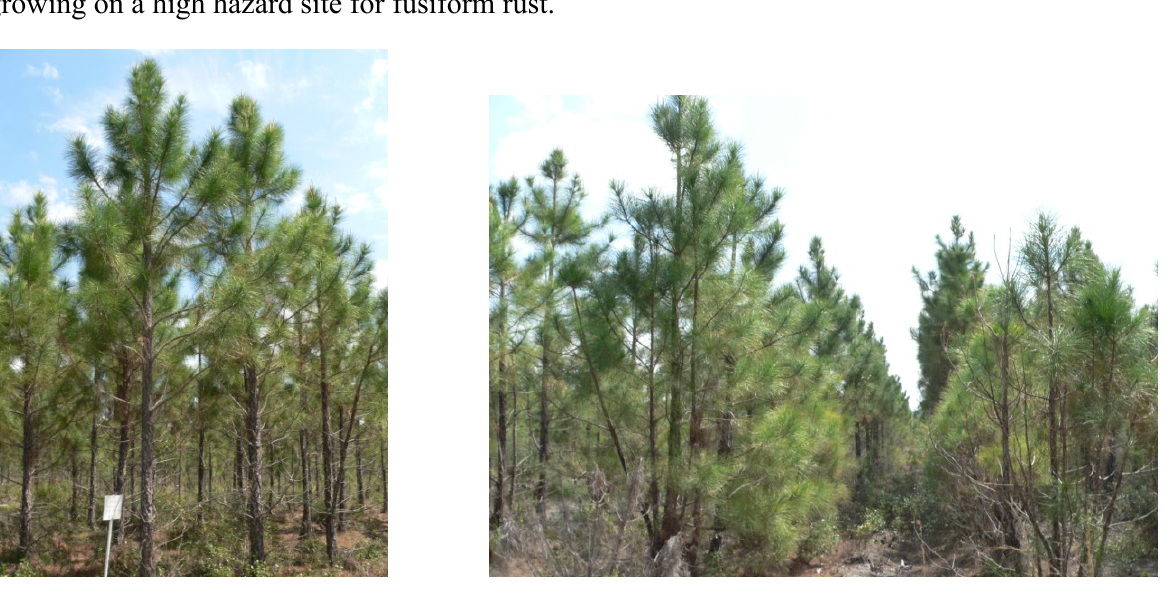
Figure 8. Two contrasting slash pine families, resistant ( left ) with 7% incidence and susceptible ( right , showing branchy, deformed trees) with 87% incidence. Both are growing on a high hazard site for fusiform